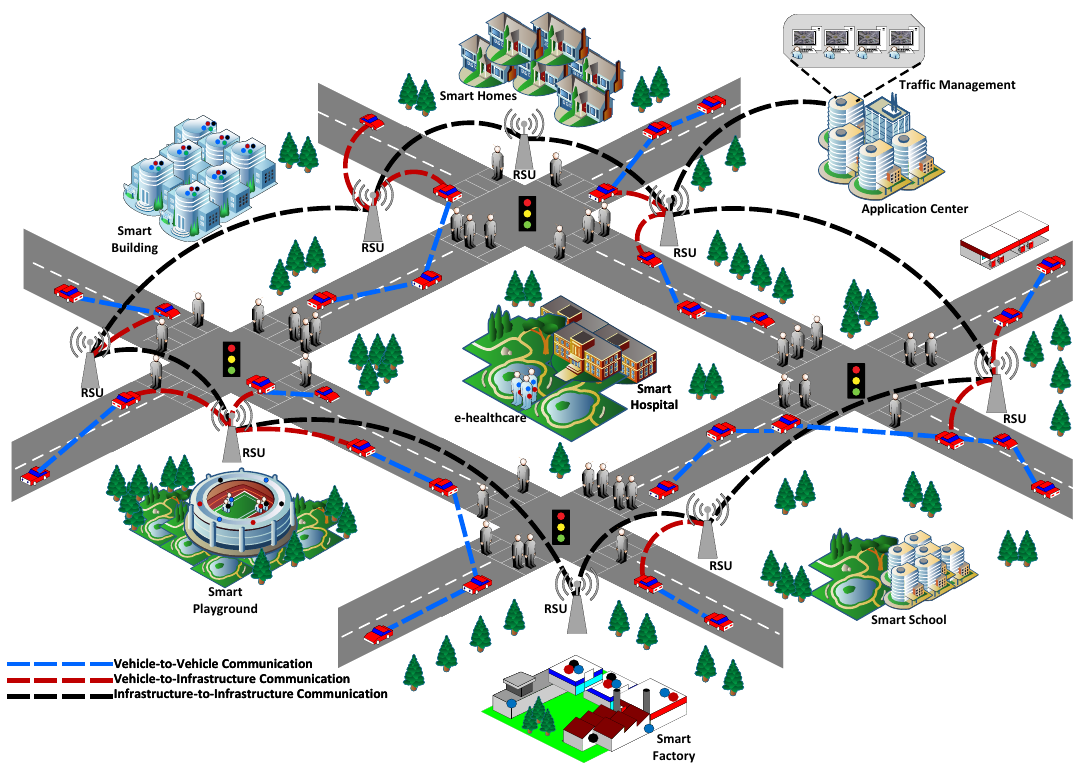
Figure 1. Illustration of VANET in smart